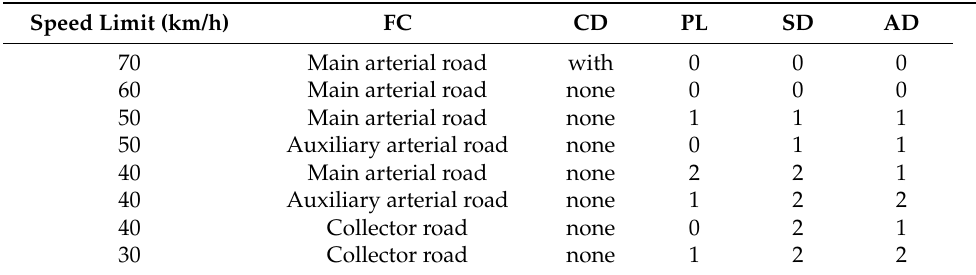
Table 15. Classification of speed limit groups according to the road environment. Speed Limit